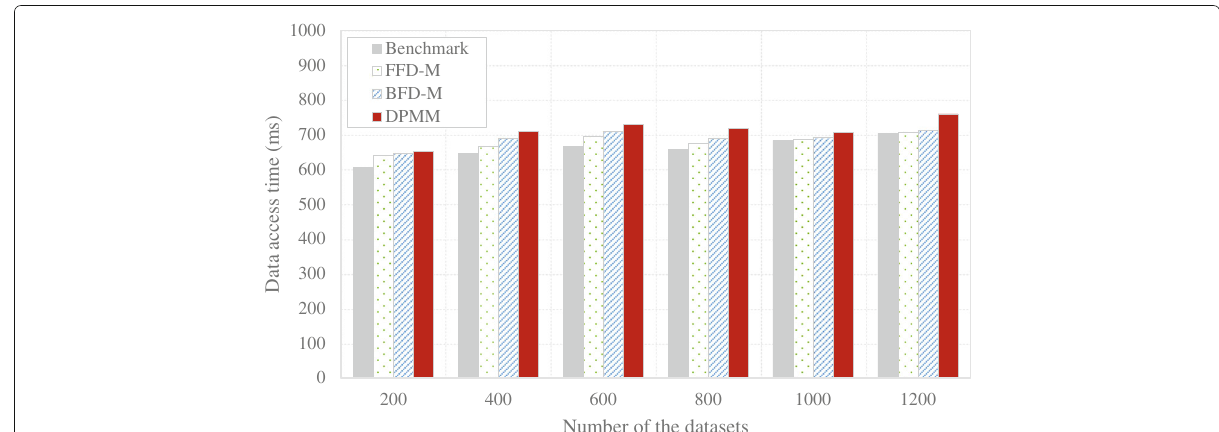
Fig. 7 Comparison of the data access time of the meteorological tasks of Benchmark, FFD-M, BFD-M, and DPMM at different dataset scales